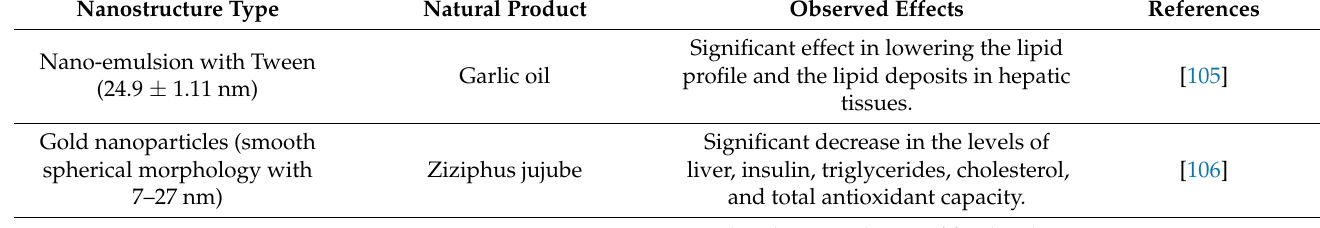
Table 6. Natural nanostructures and their therapeutic roles in the management of